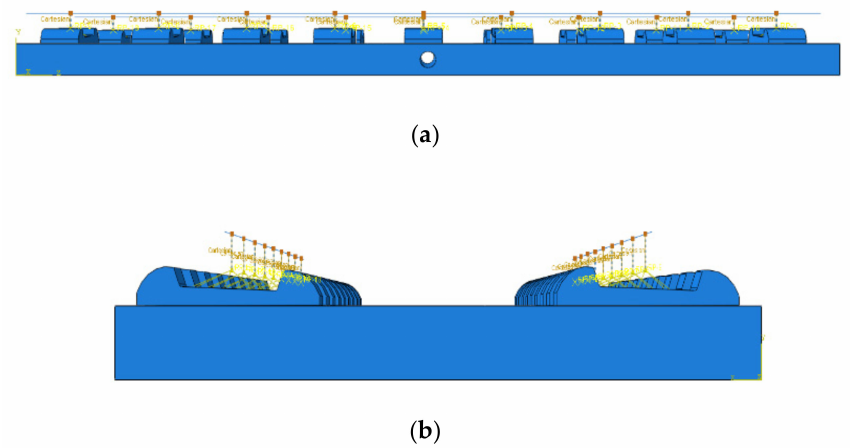
Figure 6. The model of rail and fastener system: ( a ) Side view; ( b ) Main